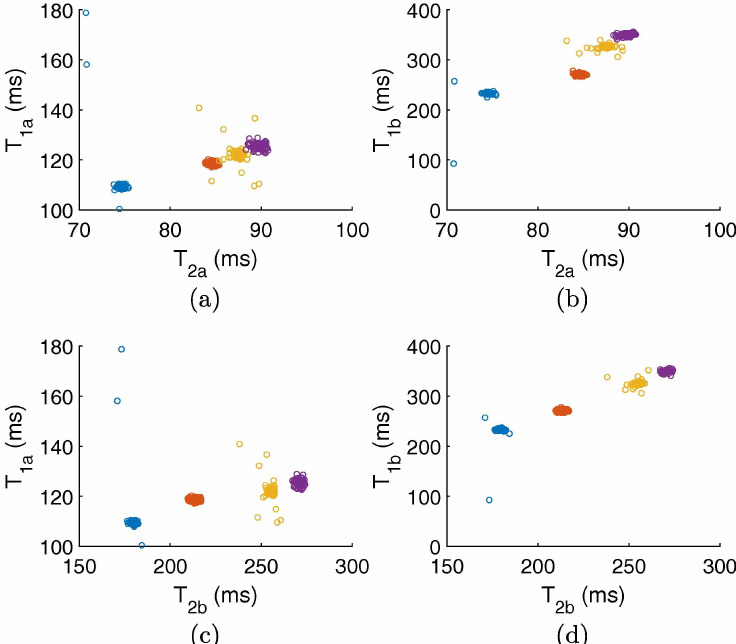
Figure 19. T 1 –T 2 correlational maps classifying several kinds of oils: olive (blue), canola (orange), corn (yellow) and vegetable (purple) by using the two components used by the Gaussian fit of those peaks revealed by the inverse 2D Laplace transform. ( a , c ) report the first component of T 1 versus the first and second components of T 2 , respectively. ( b , d ) report the second component of T 1 versus the first and second components of T 2 , respectively. See main text and Ref. [116] for details. Figure reprinted with permission from Ref. [116]. Copyright 2018 Elsevier.